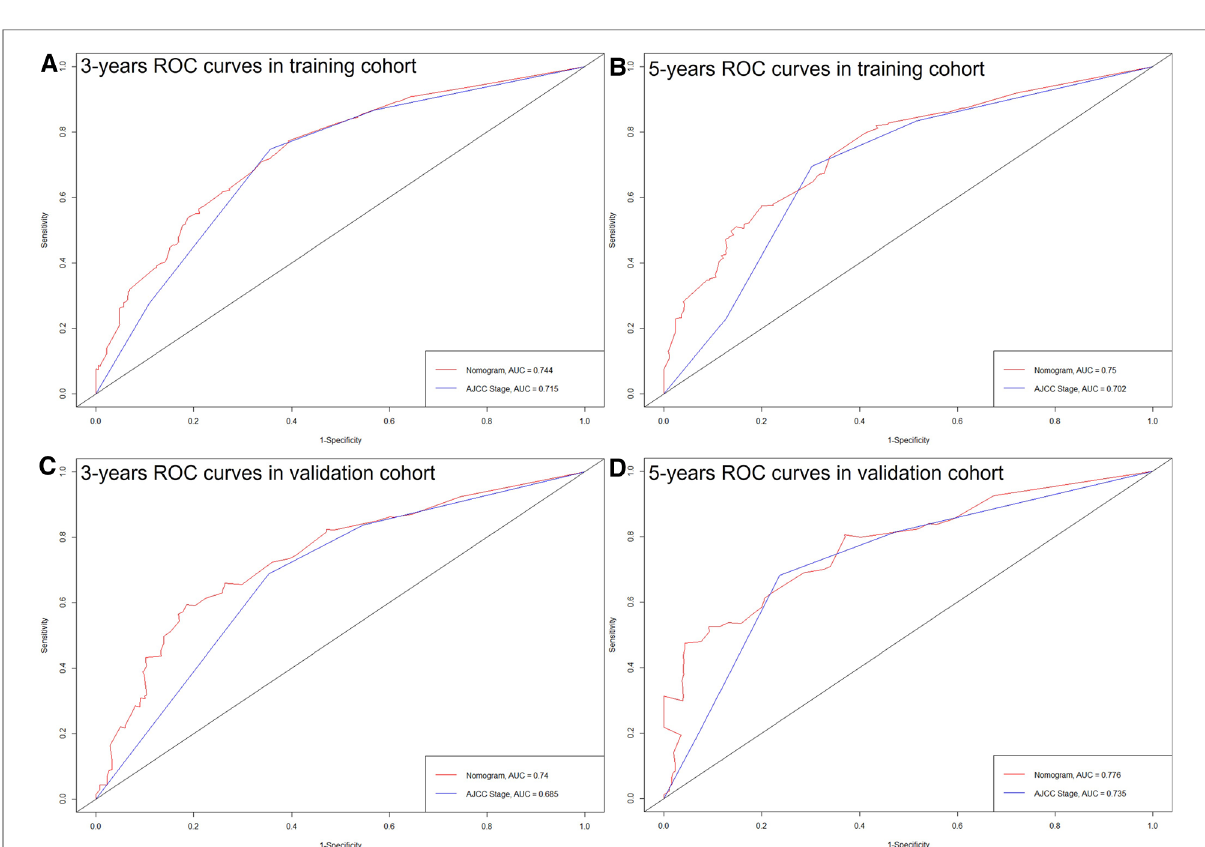
FIGURE 4 ROC curves of the nomogram and the AJCC staging system. ( A ) 3 years in training cohort; ( B ) 5 years in training cohort; ( C ) 3 years in validation cohort; ( D ) 5 years in validation